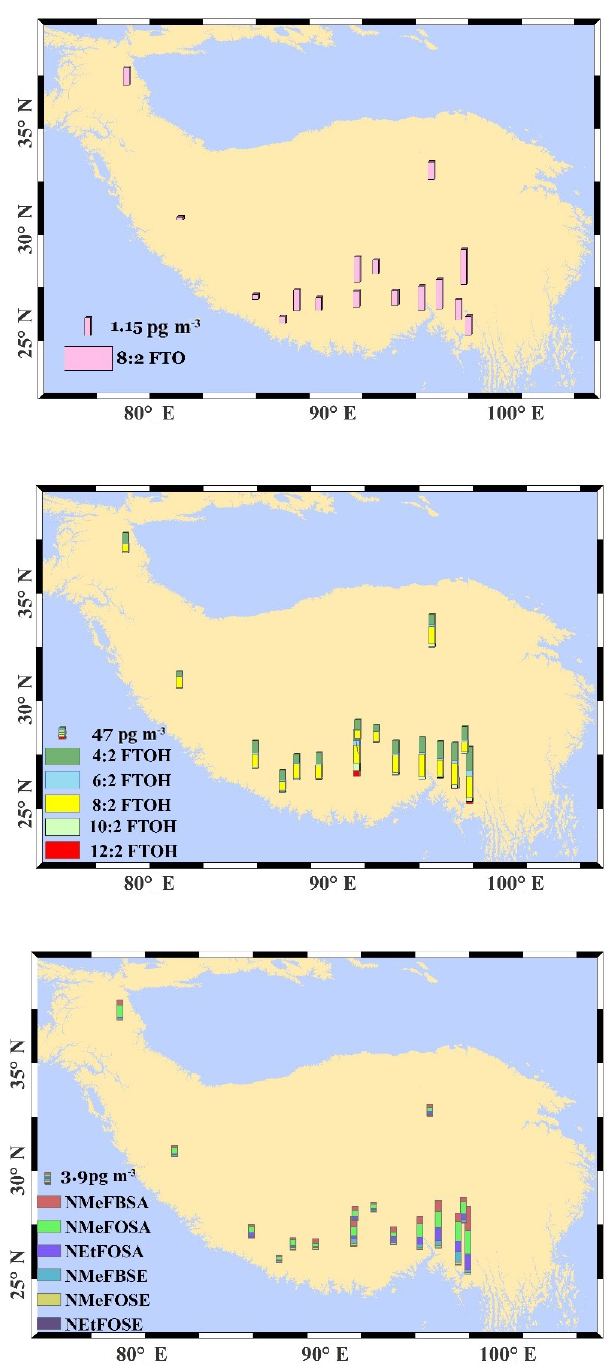
Figure 1. Spatial distribution of neutral PFASs in the atmosphere of the